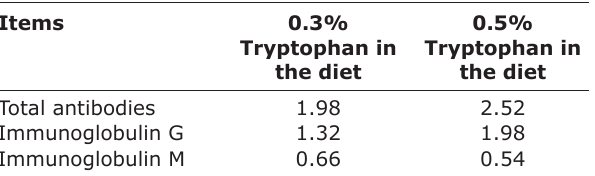
Table-4: The effect of Tryptophan on immunity of chickens from 7-21 days.